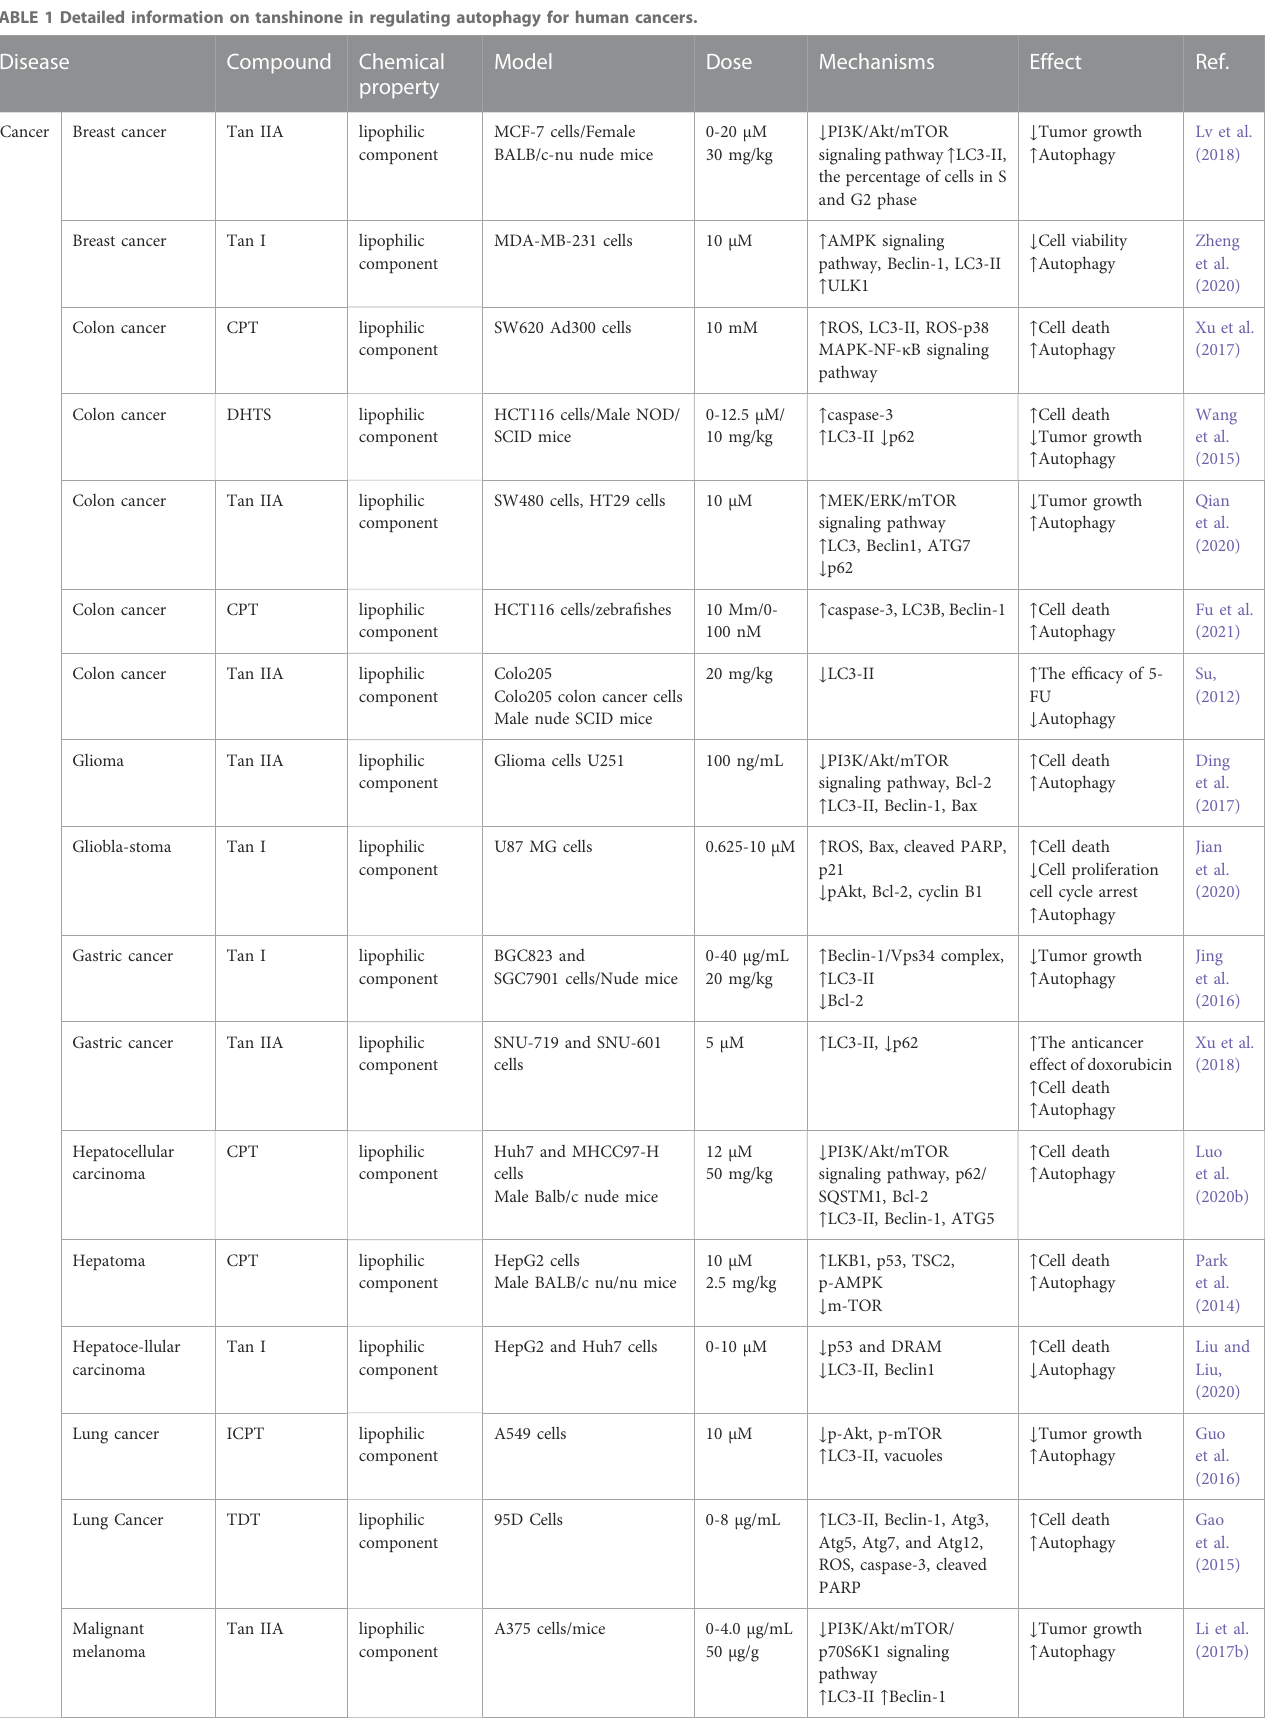
TABLE 1 Detailed information on tanshinone in regulating autophagy for human cancers.